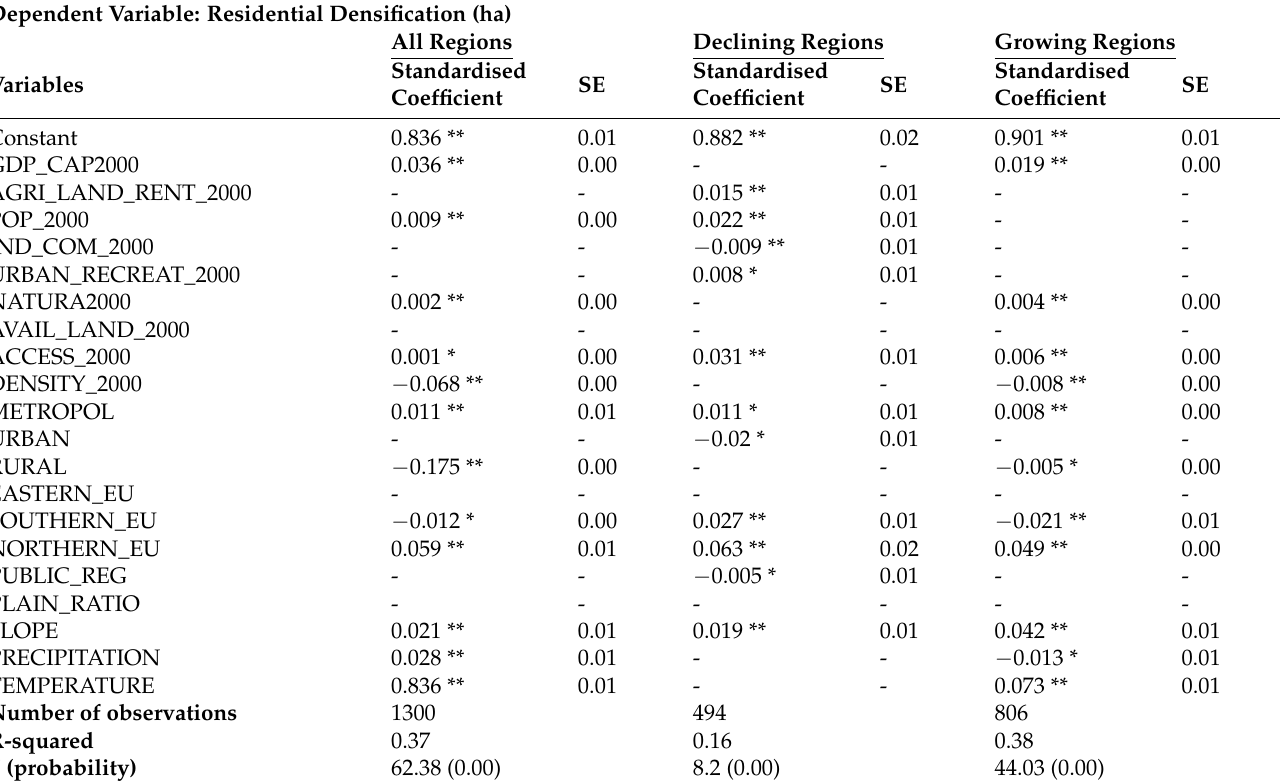
Table 4. Results of regression analysis explaining residential densification in EU